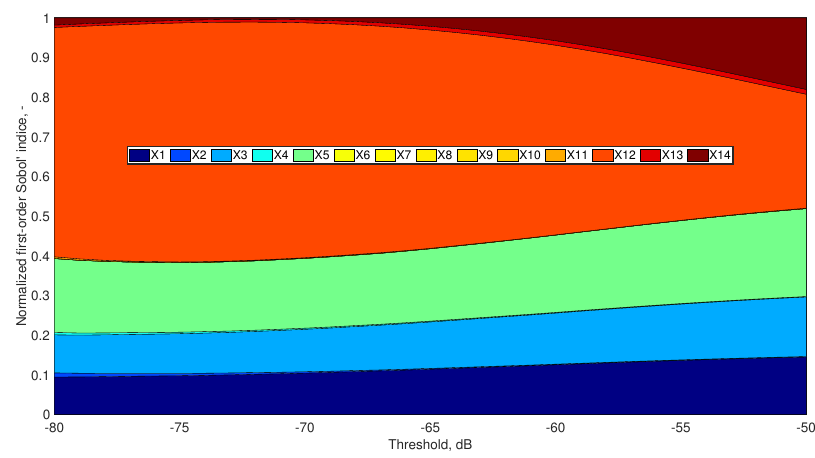
Figure 23. Normalized first-order Sobol’ indices from Test case #2/Channel #1 (14 RVs). As previously highlighted, the results show the overwhelming importance of source and load variations, depending on T assumptions: